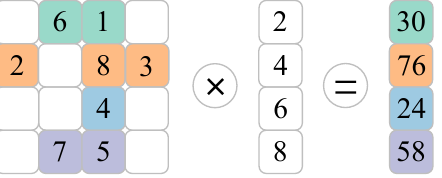
Figure 1. A SpMV example with a 4 × 4 matrix and a